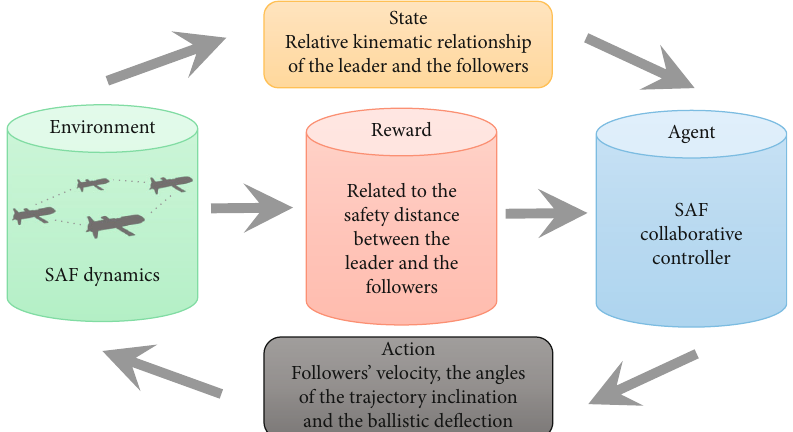
Figure 2: The MDP framework of the SAF collaborative control.